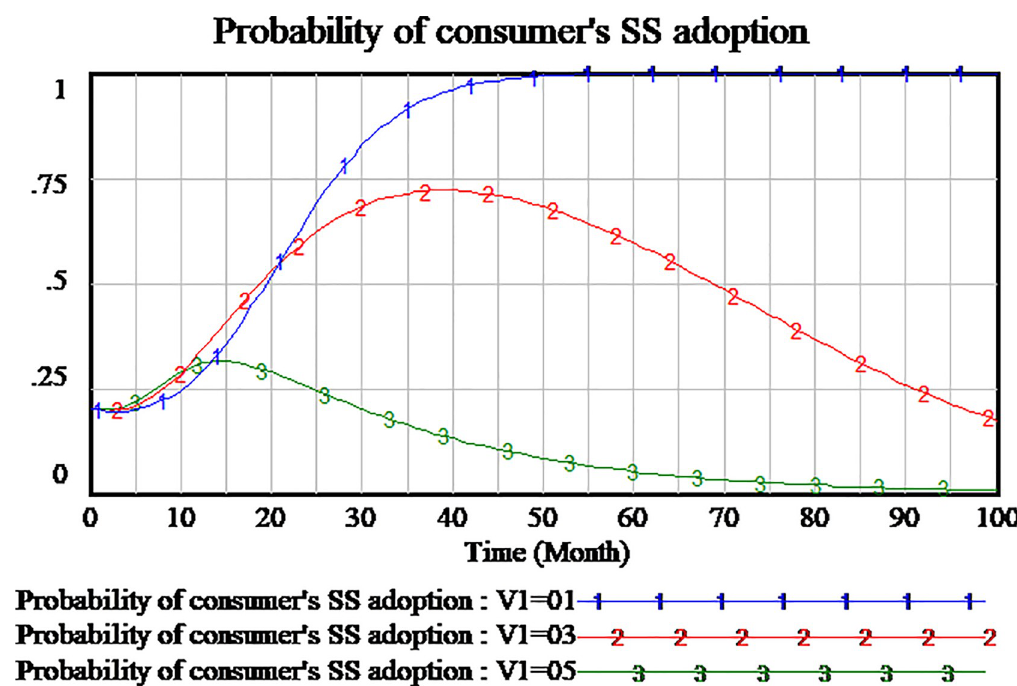
Fig 11. Impact of different penalty on government.